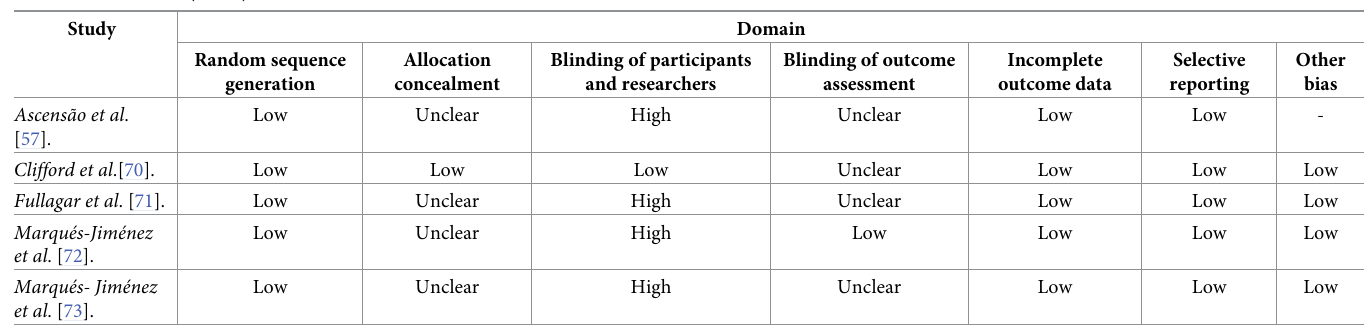
Table 2. Risk of bias (RCTs).